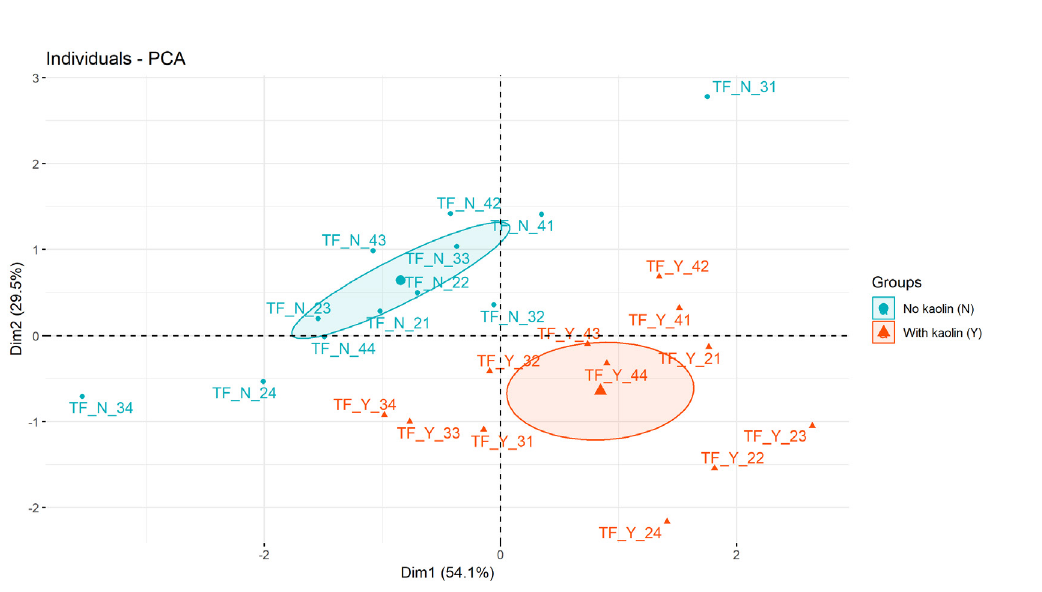
Figure 4: Principal Component Analysis for kaolin treatment in Touriga Franca (TF) leaves. The first digit refers to the days after application (DAA): 2: DAA 44; 3: DAA 57; 4: DAA 85 and the second digit is the repetition number